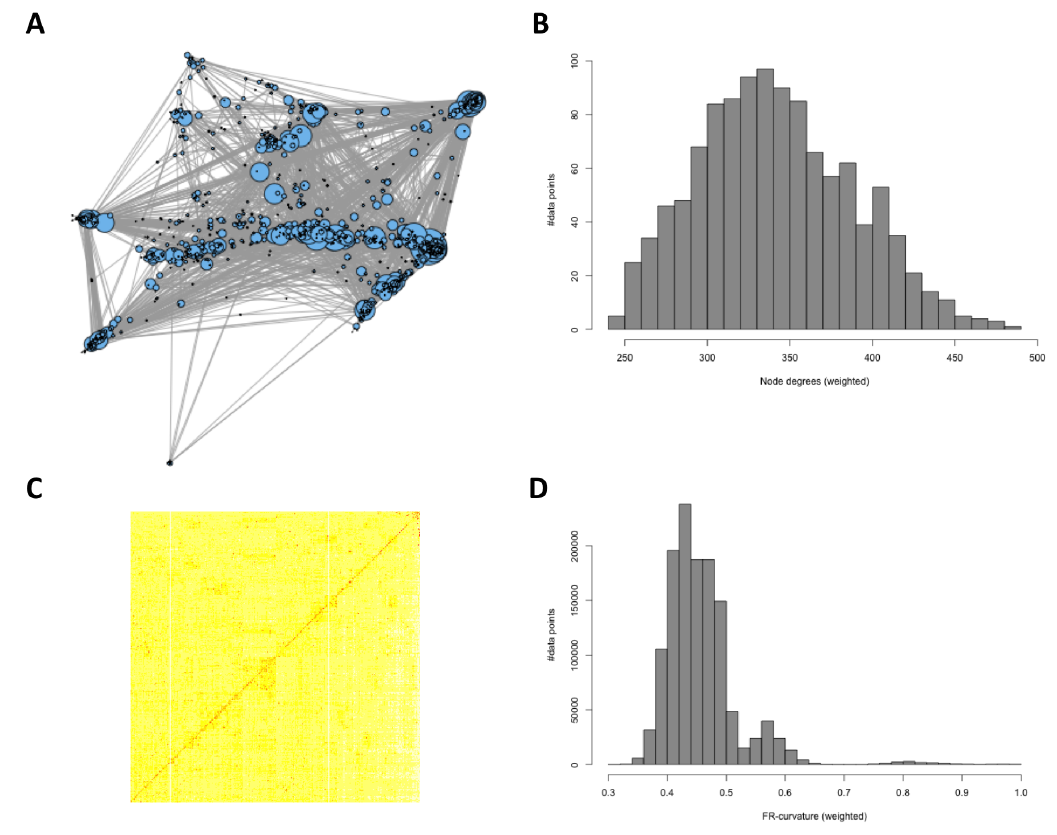
Figure 1. Characterization of a weighted and undirected peer-to-peer network (email correspondence [33,38]) with Forman-Ricci-curvature; ( A ) Network plot. Node sizes are scaled with respect to their node degrees; ( B ) (Weighted) node degree distribution; ( C ) Curvature map, representing the Forman-Ricci-curvature along the network’s edges. The curvature map consists of a heat map of a matrix where each entry ( i , j ) represents the Ricci curvature of the corresponding edge Ric ( e = e ( i , j )) . Light yellow entries resemble edges with low curvature, red entries resemble those with high curvature; ( D ) Histogram showing the distribution of the